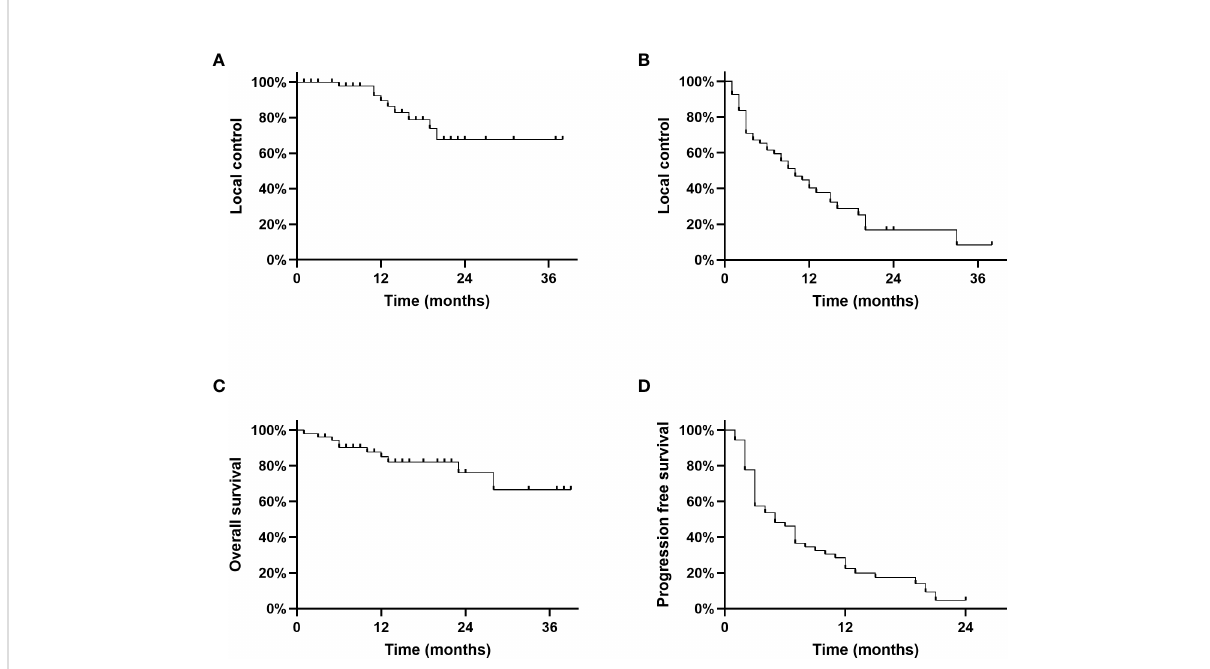
FIGURE 1 (A) : Local control of the irradiated liver lesion, (B) : Local control rate of the liver, (C) : Overall survival, (D) : Progression free